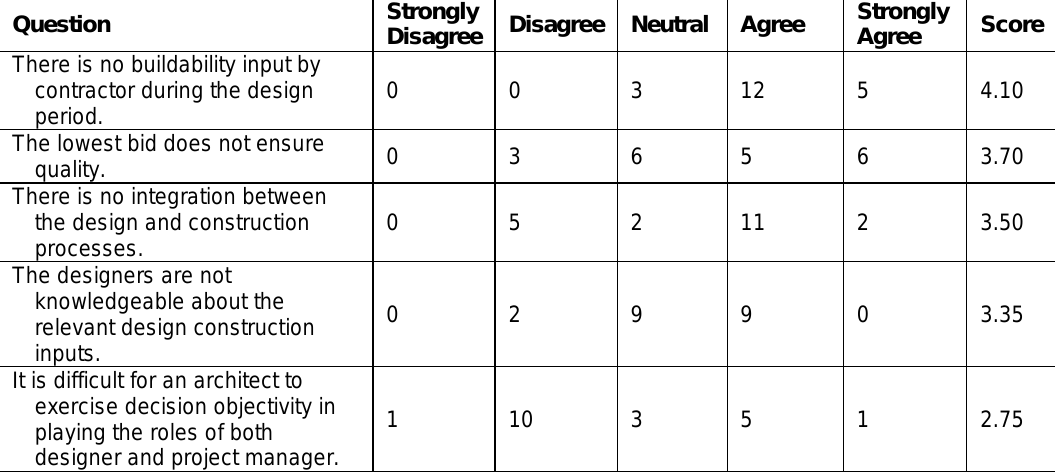
Table 3: Effects on